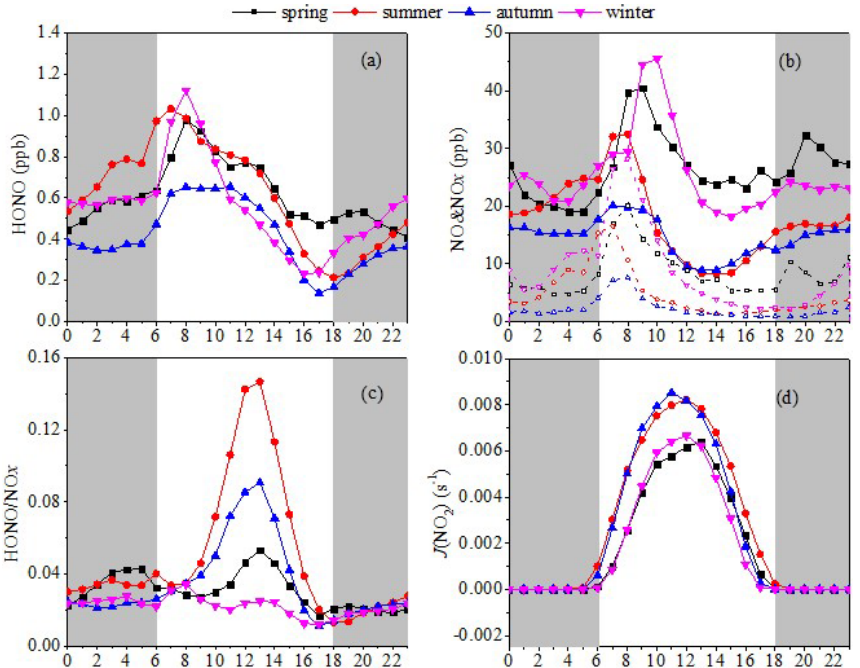
Figure 3. Diurnal variations in (a) HONO, (b) NO (hollow markers and dashed lines) and NO x (solid markers/lines), (c) HONO / NO x , and (d) J (NO 2 ). The gray shading indicates nighttime (18:00–06:00LT, including 18:00LT).